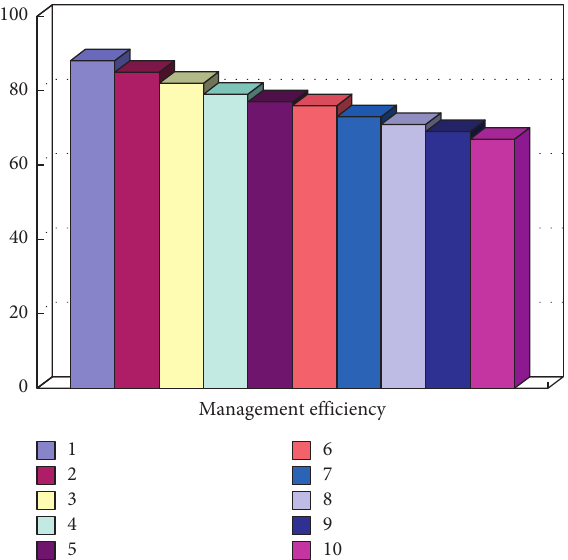
Figure 6: Experimental data table of traditional algorithm.